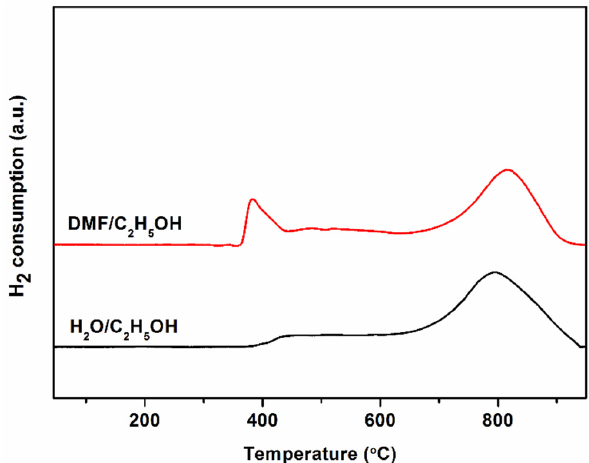
Figure 5. TPR profiles of the spent catalysts prepared with different solvents.